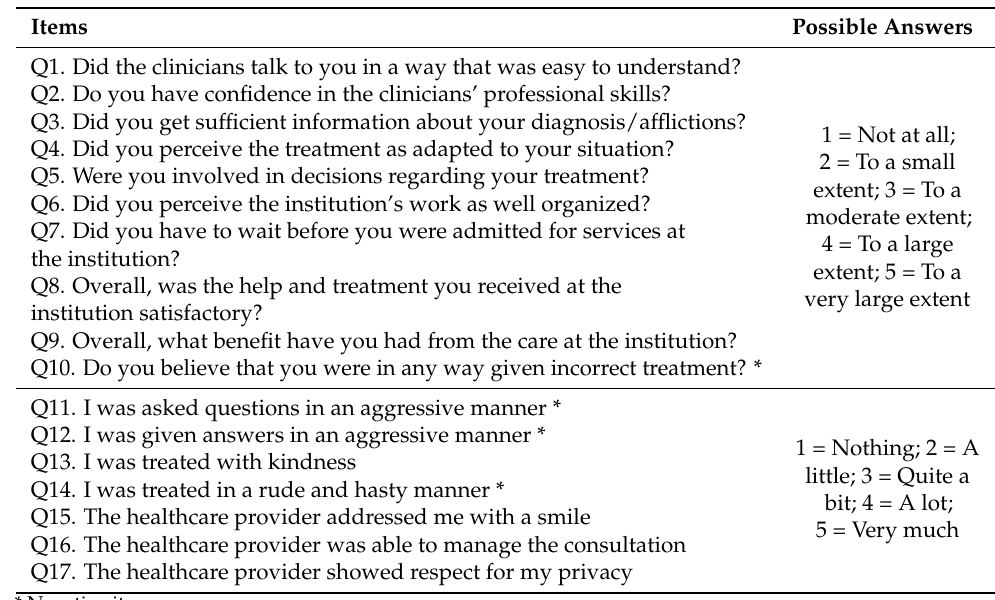
Table 1. Patient experiences and communication